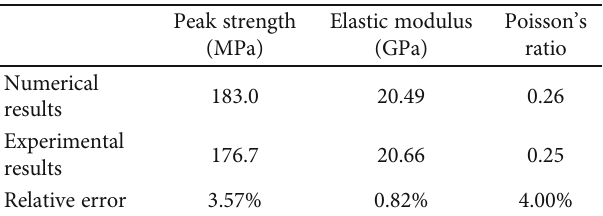
Table 2: Comparison between experimental and numerical mechanical parameters of the intact